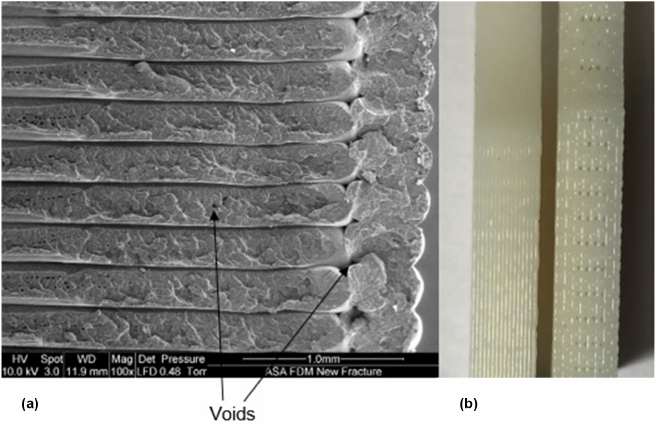
Figure 1. Voids in the FDM printed parts. ( a ) Scanning Electron Microscope (SEM) image showing usual voids inherent to the FDM process. ( b ) Optical image of a dog-bone sample with clearly seen